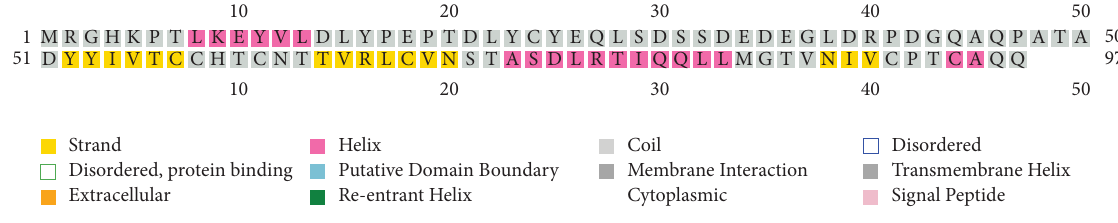
Figure 5: Te secondary structure of HPV33 E7 protein.